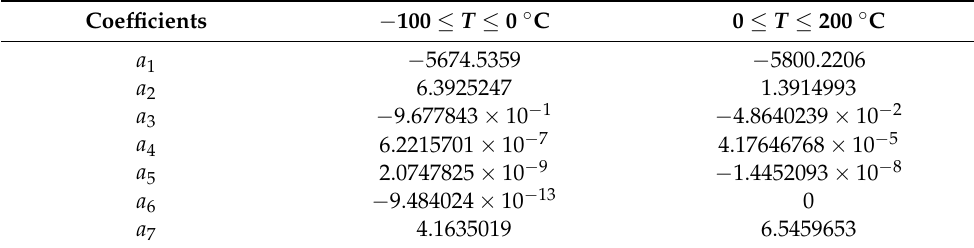
Table 2. Coefficients in the water vapor saturation pressure